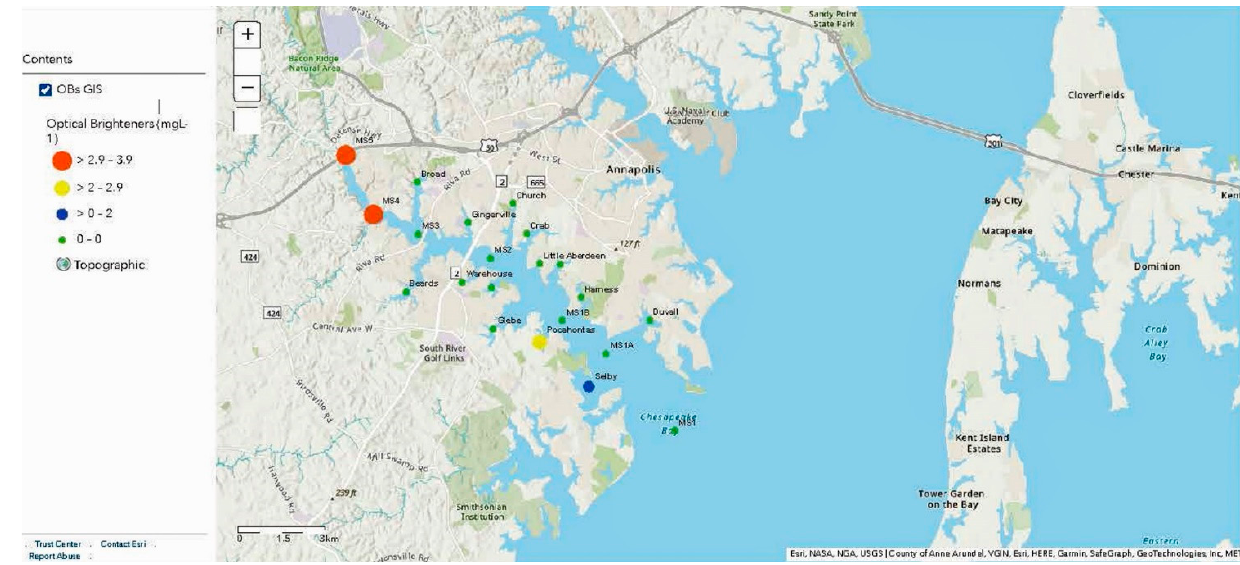
Figure 8. GIS map of Optical Brightener concentrations in the South River Estuary and corresponding triblets. Median values of Oils indicate high values near the headwaters of the South River value reported was Harness Creek Triblet (HAR), 45.76 mg L − 1 , on 29 October 2013. On BRD, with concentrations above 20 mg L − 1 .